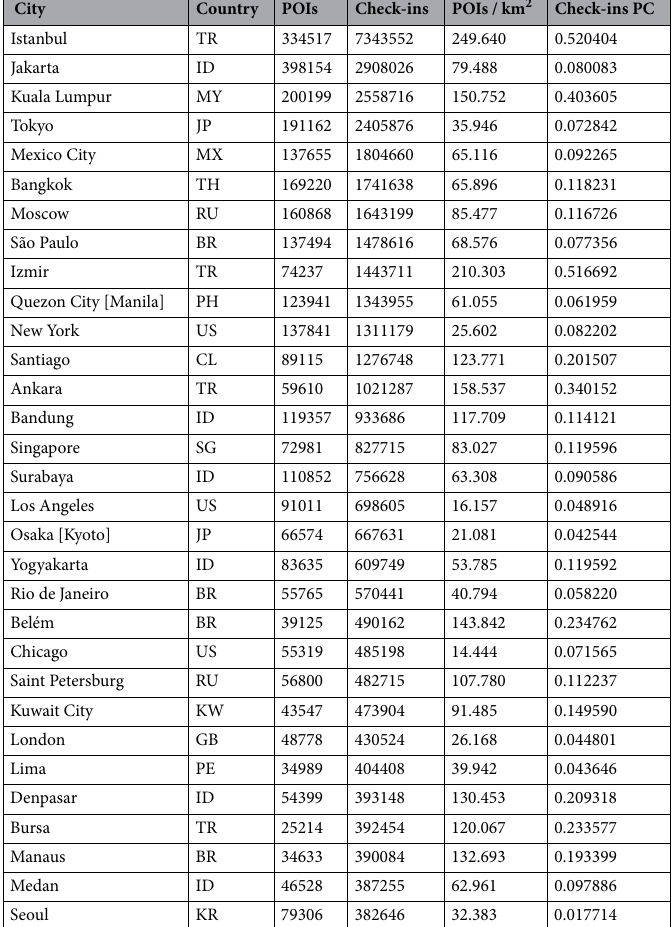
Table 2. Foursquare data by city. The 31 cities with the highest number of check-ins are shown. This selection contains information on a wide variety of countries with different geographic, cultural, linguistic, economic, and religious